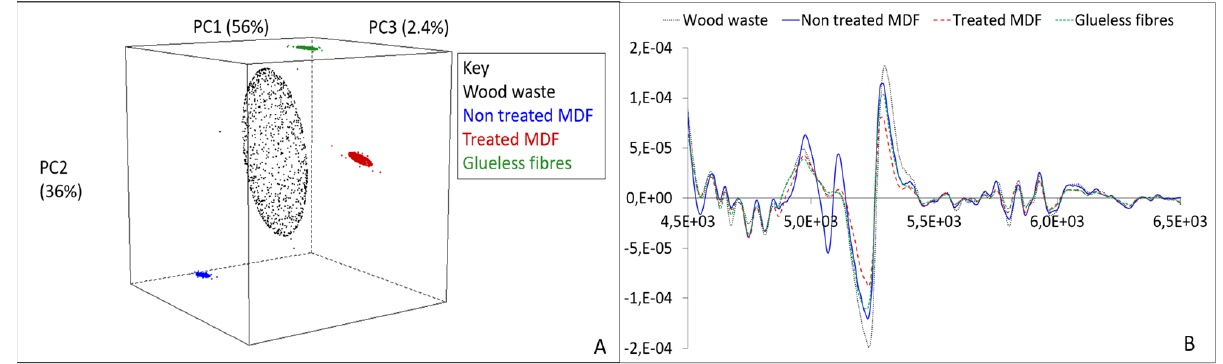
Figure 6. Principal component analysis performed on four wood products-plastic composites ( A ) and loadings analysis ( B ) (non-published data).